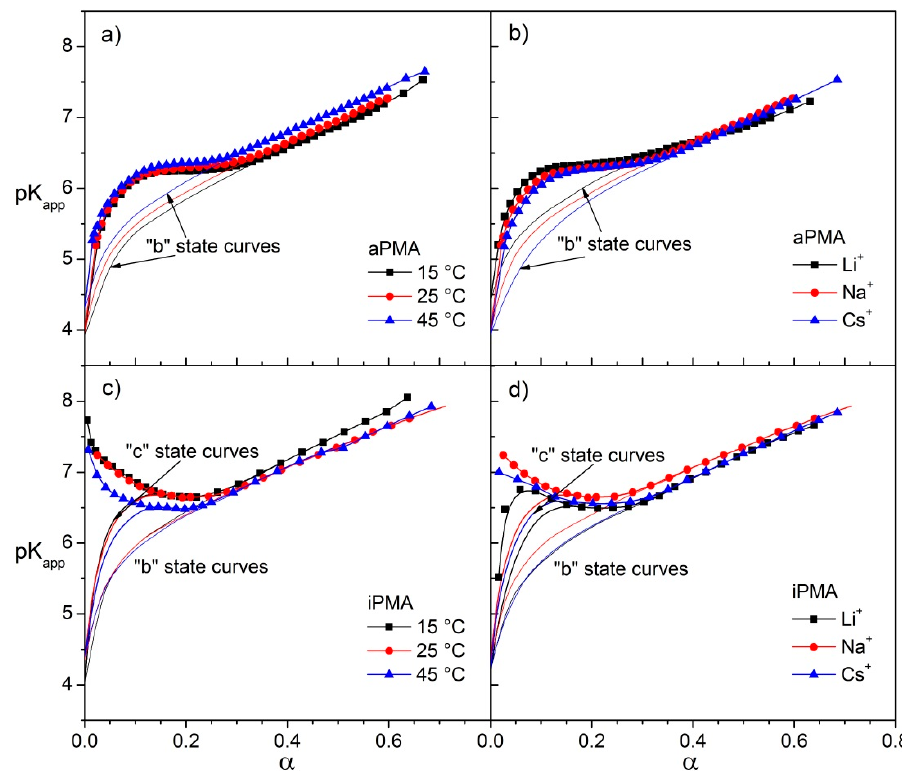
Figure 3. Potentiometric titration curves (p K app versus α ) for aPMA ( a , b ) and iPMA ( c , d ); left panel: effect of temperature ( T = 15, 25, 45 °C) in 0.01 M NaCl; right panel: effect of counterion in 0.01 M XCls (X = Li, Na, Cs) at 25 °C. Filled symbols (together with the lines) are the experimental data (“a” state curves), dotted lines are the “b” state curves and solid lines are the “c” state or hypothetical curves for iPMA. For details on how the “b” and “c” state curves were obtained see text and Supplementary Materials.